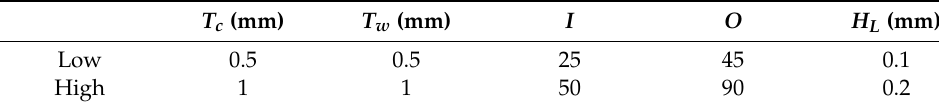
Table 4. Uncoded low and high values for each DOE factor.